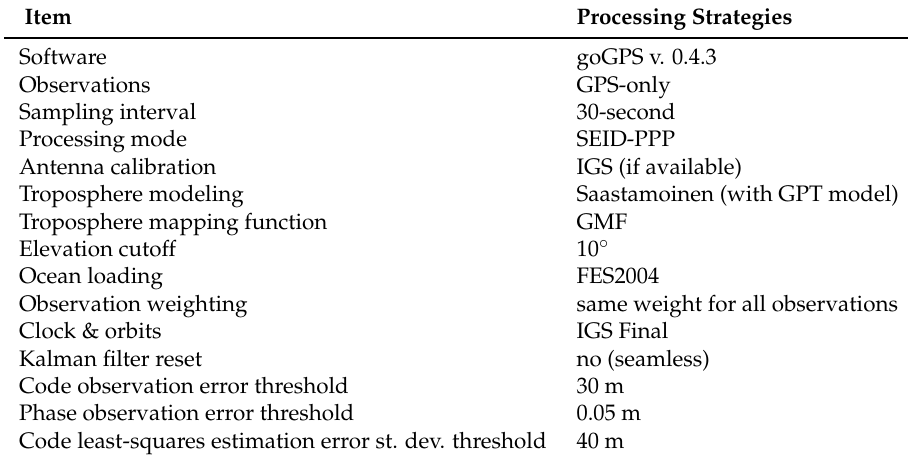
Table 1. SEID and ZTD Computation